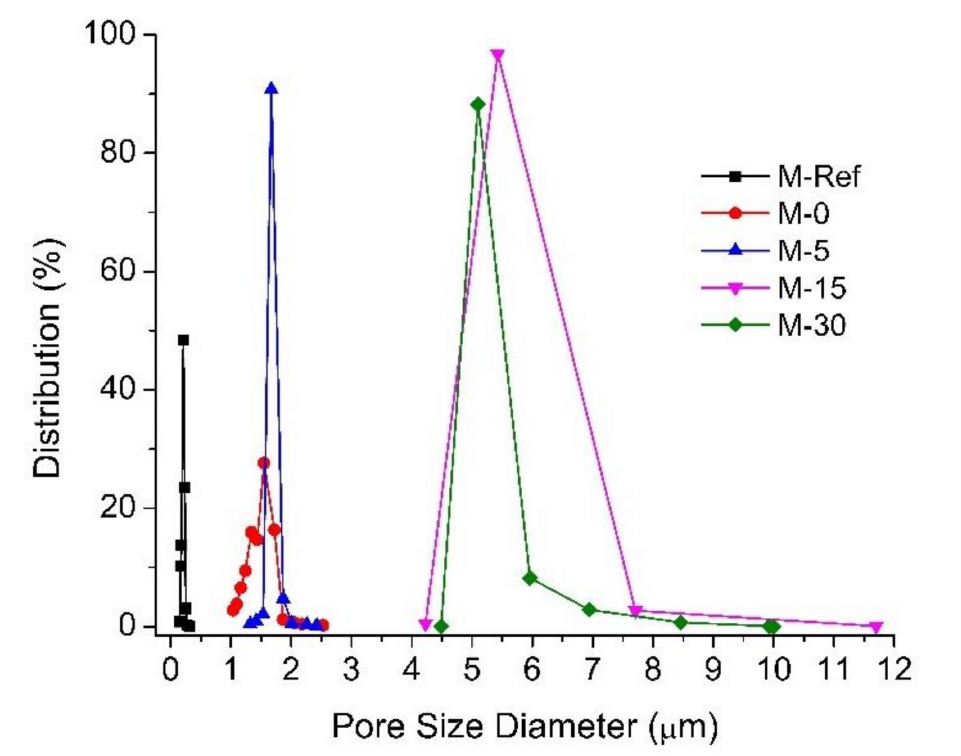
Figure 4. Pore size distribution of the resulting